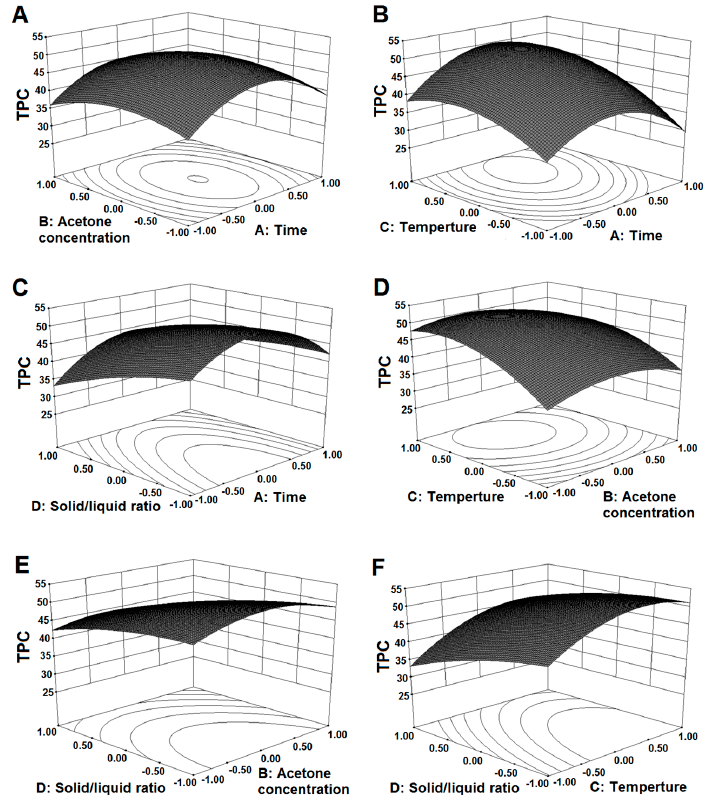
Figure 1. Response surface plots for the effect of acetone concentration and time ( A ); temperature and time ( B ); solid/liquid ratio and time ( C ); temperature and acetone concentration ( D ); solid/liquid ratio and acetone concentration ( E ) and solid/liquid ratio and temperature ( F ) on the TPC (mg GAE/g DW) of KSP.